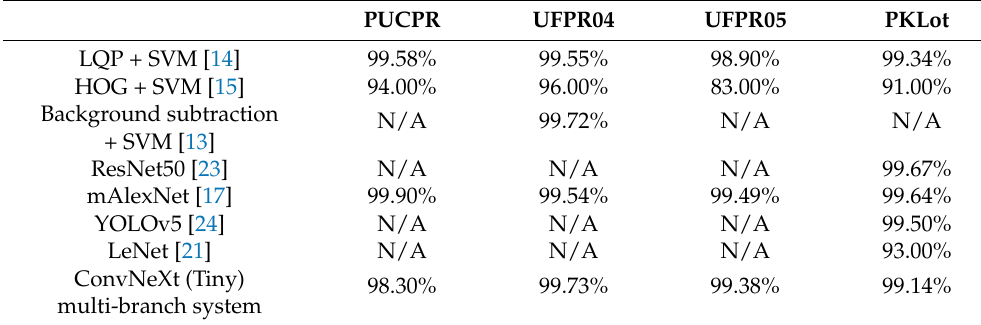
Table 8. Comparison of accuracy values with state-of-the-art works for the PCUPR, UFPR04, and UFPR05 datasets. Additionally, the average accuracy for the PKLot database has also been